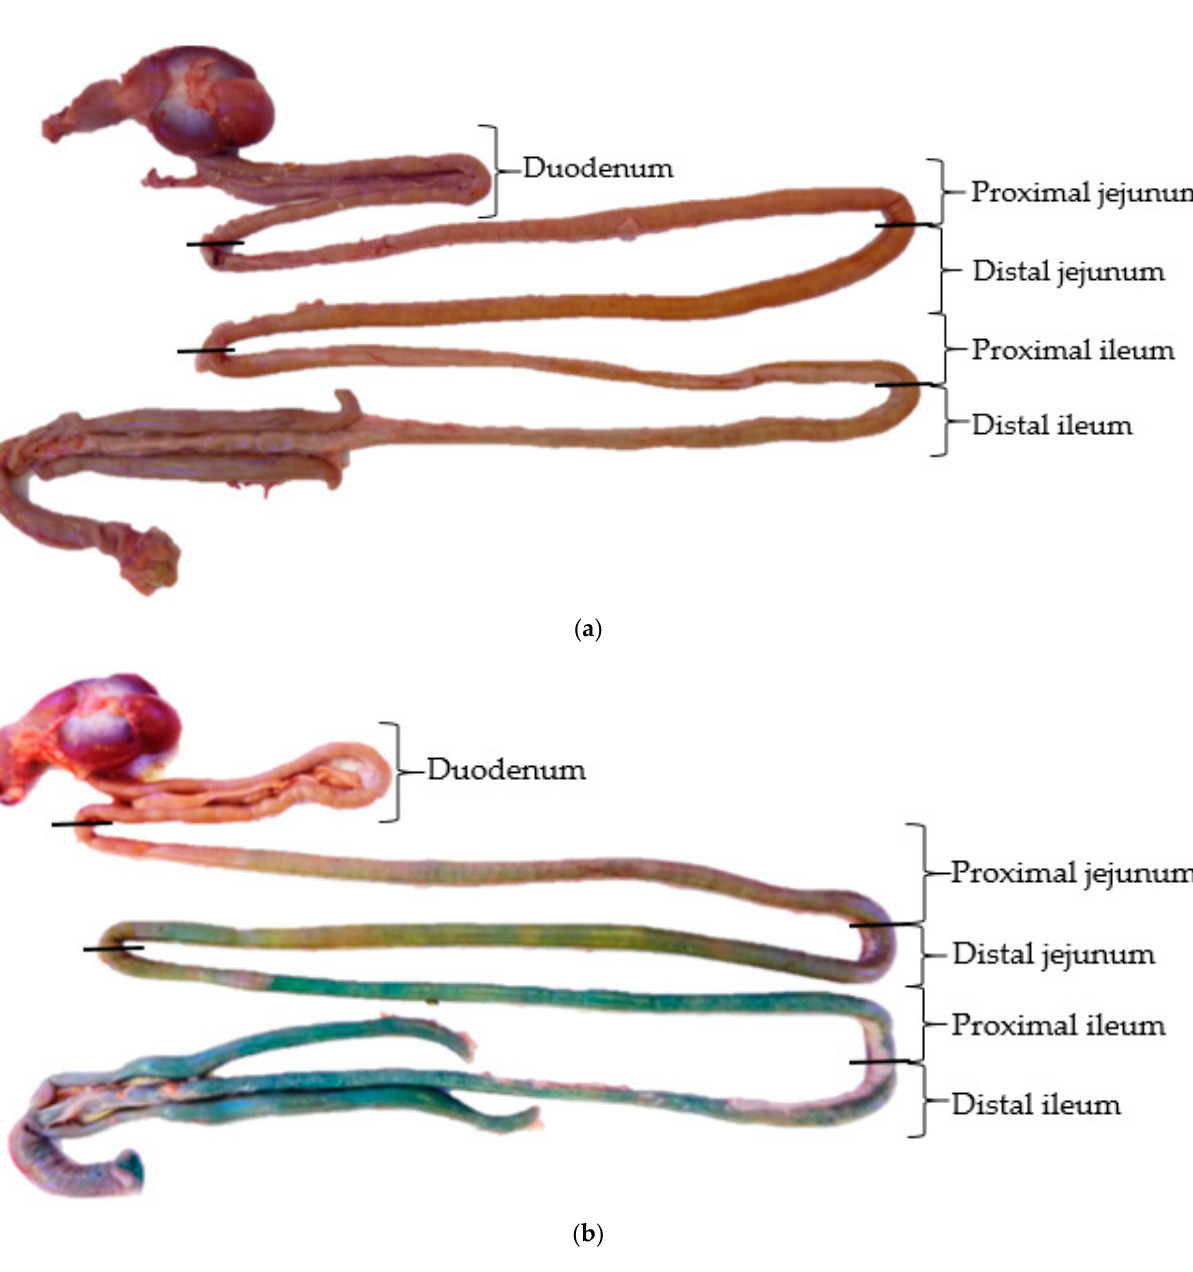
Figure 1. The GIT of a 44-day-old broiler: ( a ) non-supplemented (CTR); ( b ) supplemented with protected sodium butyrate containing protected brilliant blue dye (DIC).